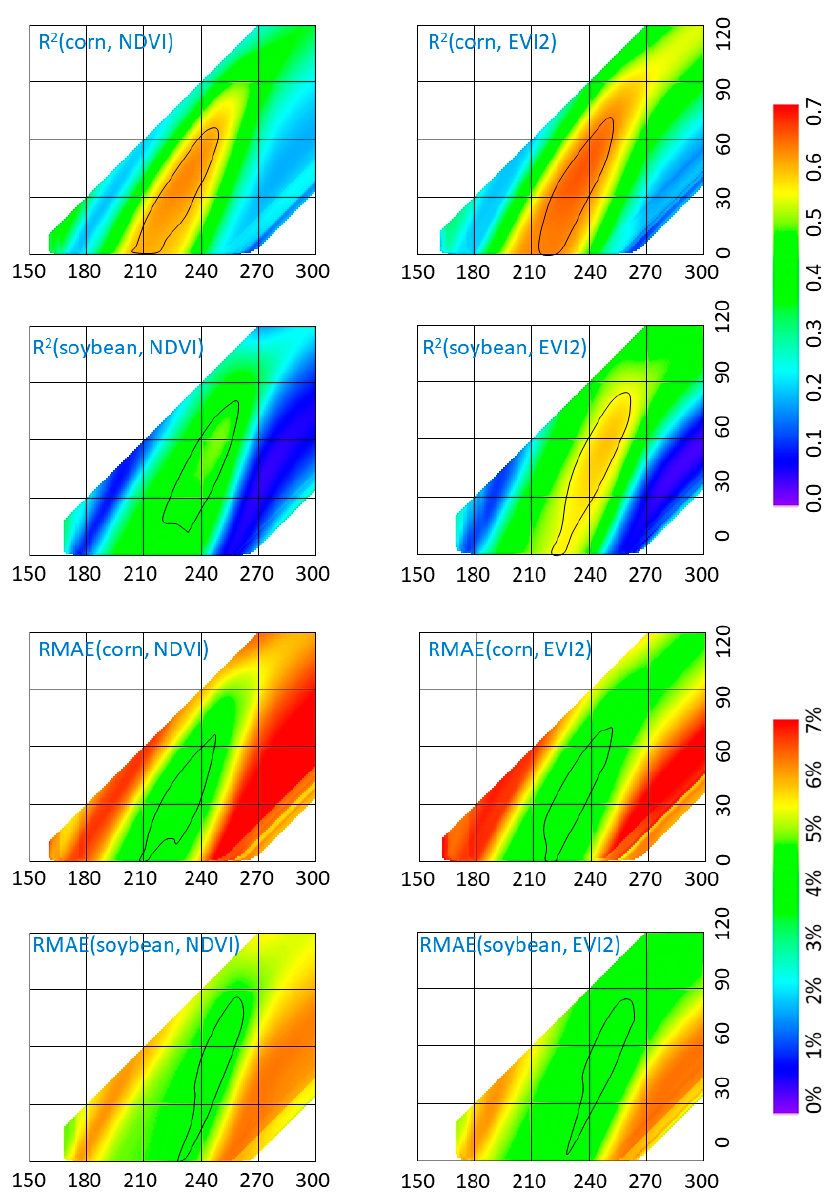
Figure 7. R 2 and RMAE of the yield with the cumulative NDVI ( left ) and EVI2 ( right ) for corn and soybean. The x -axis represents the end date and the y -axis represents the interval. The high R 2 area (highest 10%) and low RMAE area (lowest 10%) are highlighted by black contours.